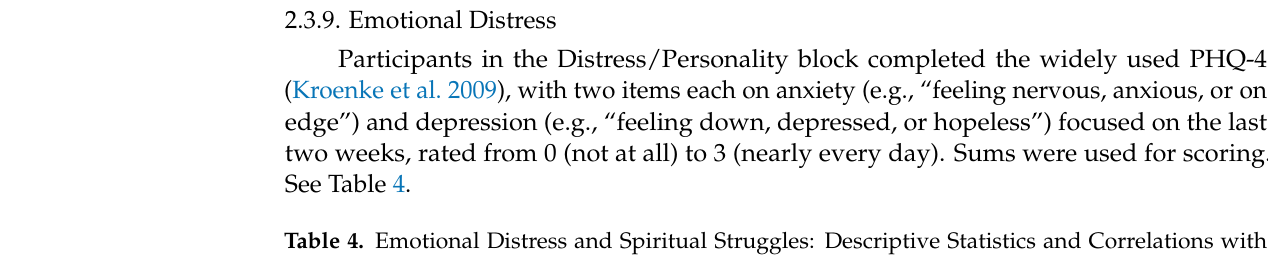
Table 4. Emotional Distress and Spiritual Struggles: Descriptive Statistics and Correlations with Demonic and Divine Attributions about